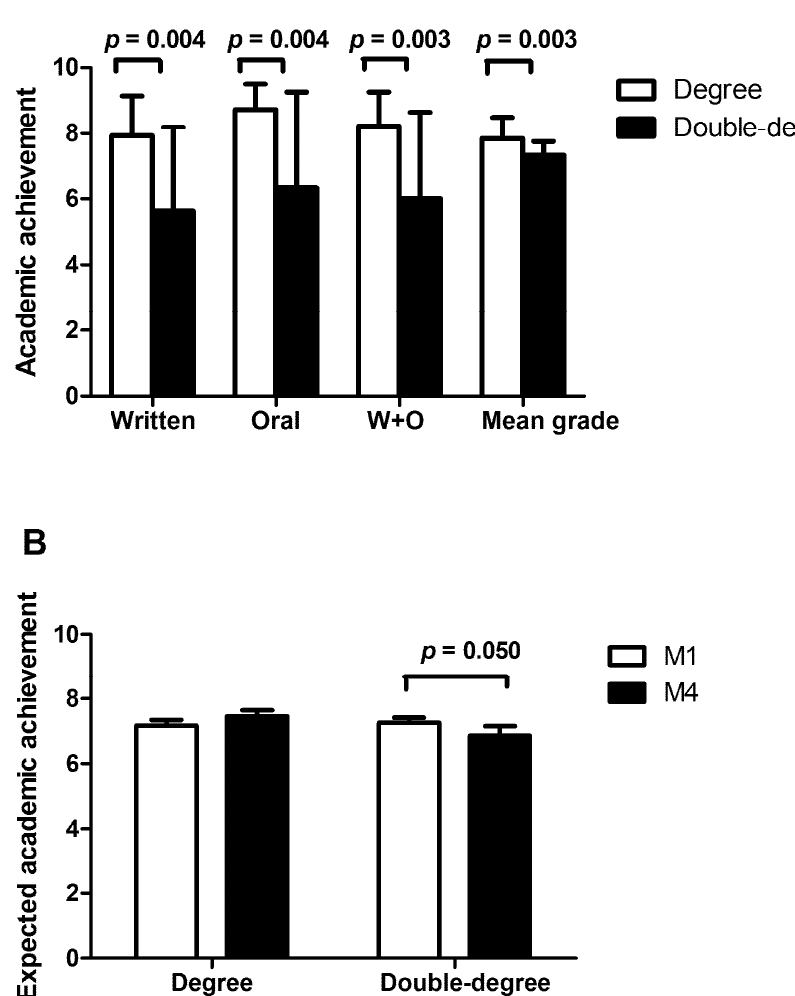
Figure 1. ( A ) Academic achievement (mean ± SD) of degree or double-degree students in the bachelor’s thesis written, oral, and written and oral achievement (W + O), and in the mean grade achievement; ( B ) expected academic achievement (mean ± SD) before (M1) and after (M4) in the bachelor’s thesis defense of degree or double-degree